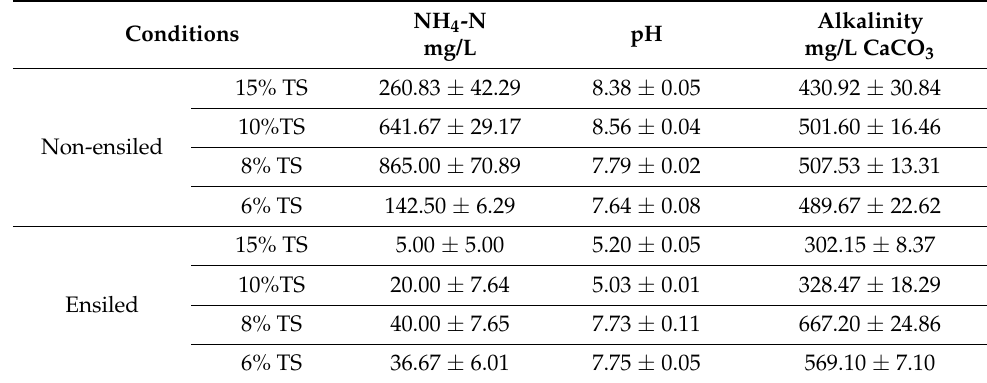
Table 2. Final characteristics of the digesters. (Average ± SE).